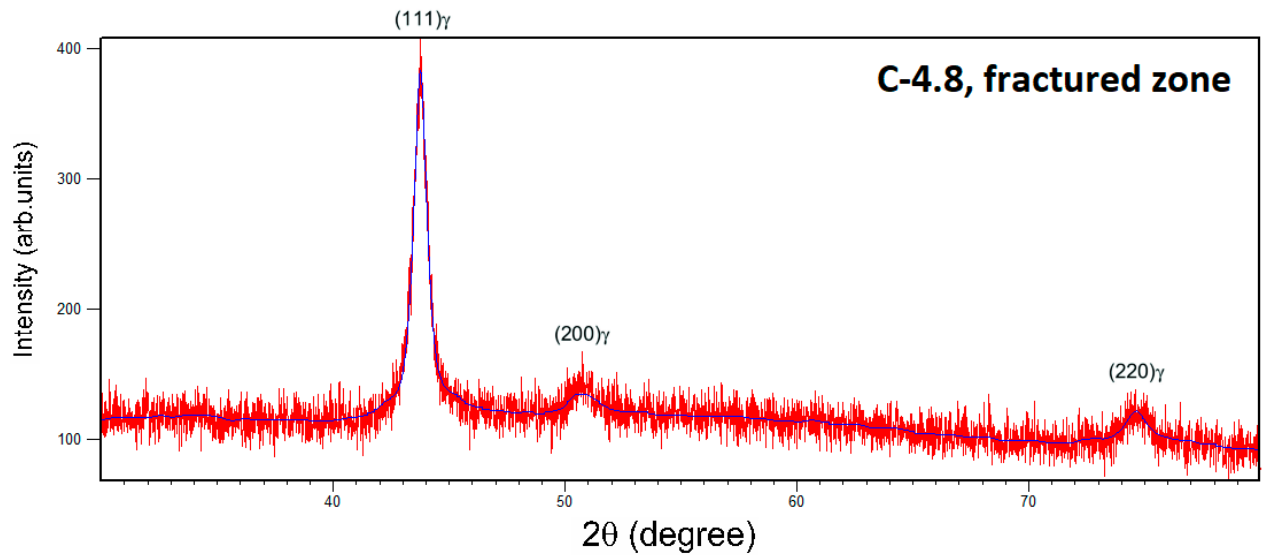
Figure 7. XRD analysis of C-4.8 sample from the fractured zone and revealing of austeinte peaks.